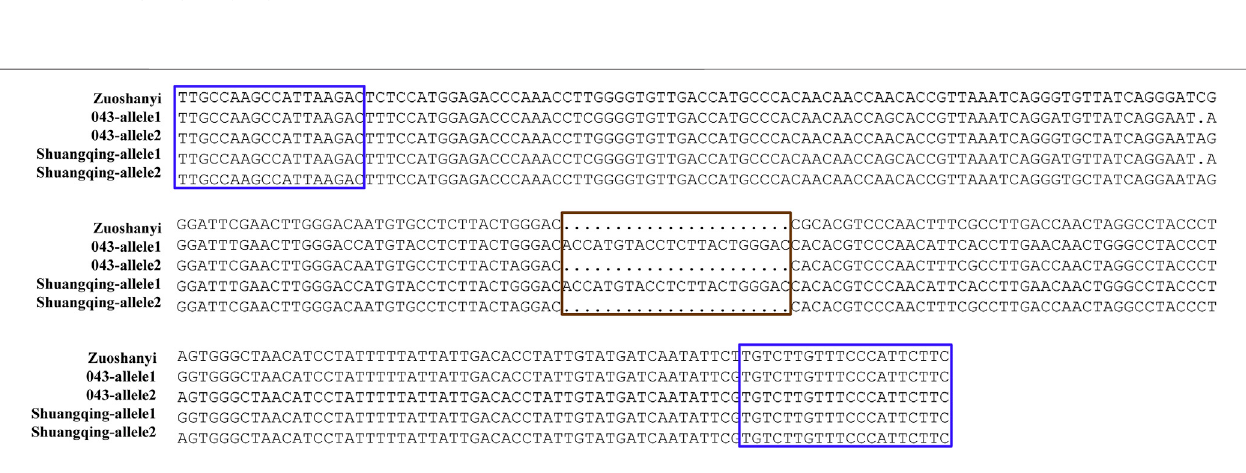
FIGURE3| Sequenceharboringthe22-bpInDelamongthreesexes.Brownbox:regionwheremaleandhermaphroditicindividualshaveanother22morebpthan femaleindividuals. Bluebox: primers used for ampli fi cation. This22-bp InDel corresponds toaninsertionbetween5195334and 5195335 bpin chromosome2ofGaze annotation of the 8 × V. vinifera reference sequence version. The location of APRT3 gene can be indicated in the 8 × V. vinifera reference sequence version, because it is absent from the 12 × version.